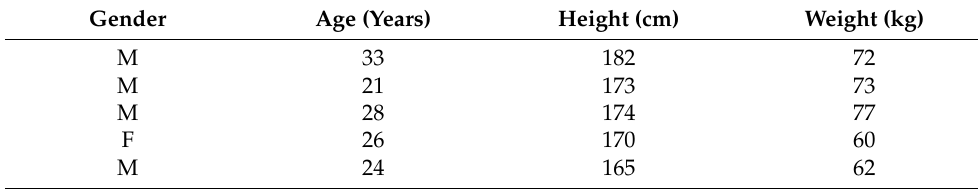
Table 2. Details of